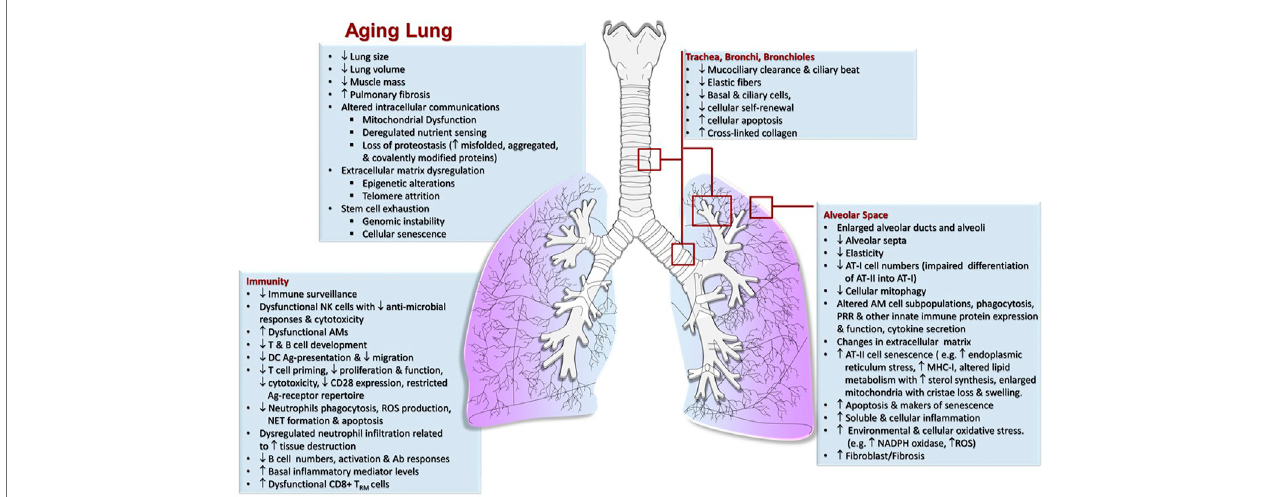
FIGURE1 | Characteristics of theAginglung. Mechanical, physiologicaland immunological (increased in fl ammation/immunosenescence) changesin the lung that take place in elderly individuals increasing the risk of airway clearance failure and susceptibility to respiratory infections.